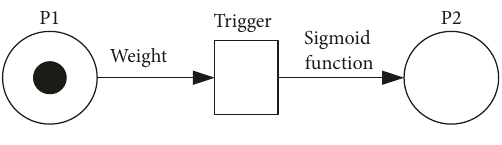
Figure 1: Improved Petri net